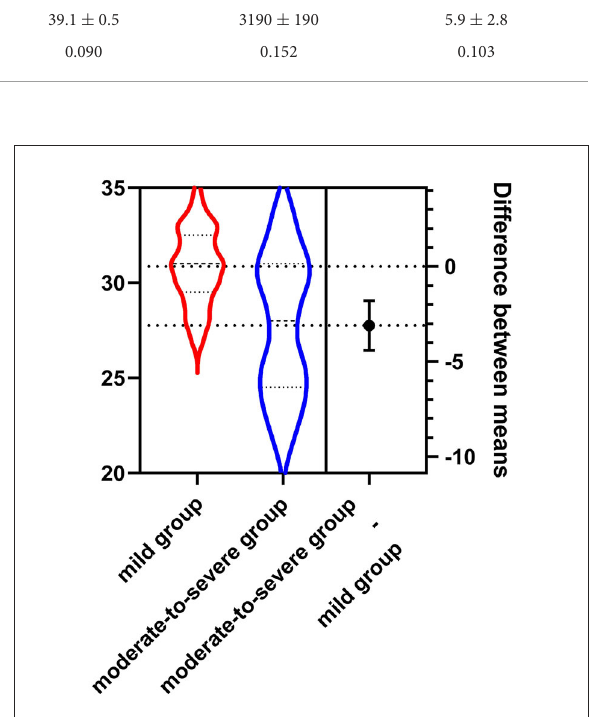
FIGURE1 The NBNA score of the mild group (30.85 ± 1.62) was higher than that of the moderate-to-severe group (27.76 ±